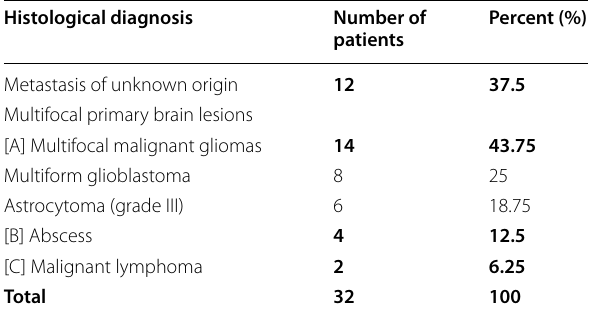
Table 1 Patients’ and peri-operative characteristics Table 2 Histopathological diagnosis in 32 patients with multiple intra-axial brain lesions made by stereotactic